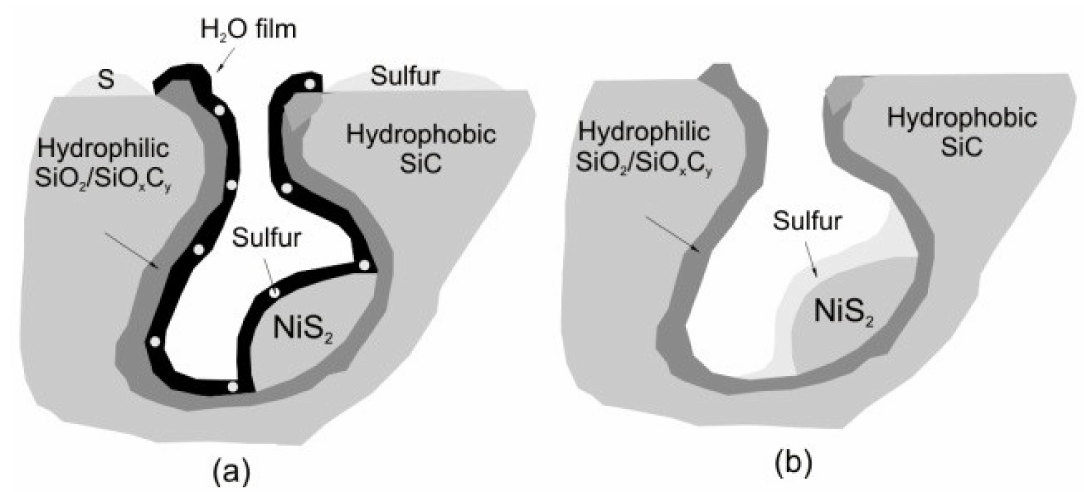
Figure 6. The tentative mechanism of sulfur deposition on the surface of a catalyst based on SiC: ( a ) in the presence of water vapor; ( b ) without water vapor (adapted from